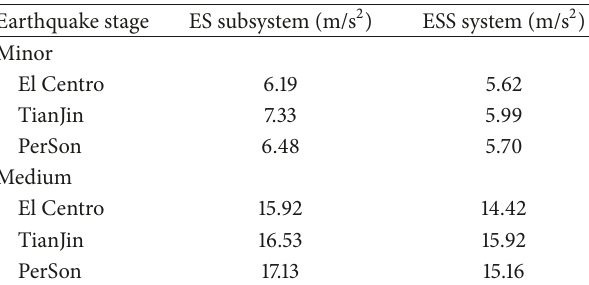
Table 3: Equipment top peak accelerations.